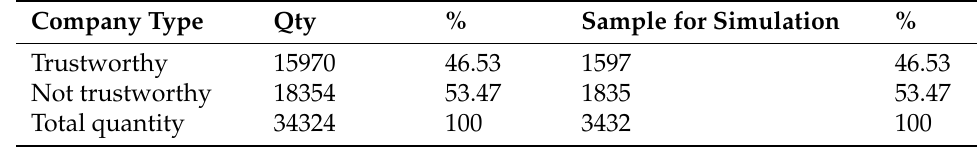
Table 1. The distribution of trustworthiness in the source sample and in the sample for modeling.